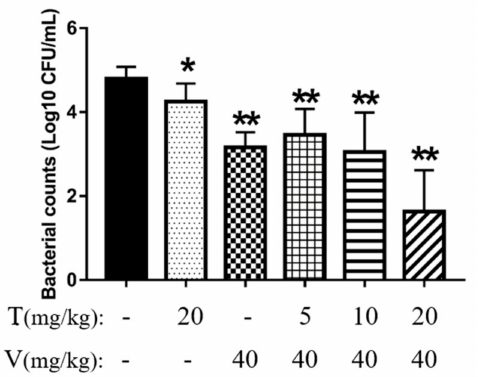
Figure 7. Bacterial counts in di ff erent mouse treatment groups. The results are expressed as the mean ± standard deviation (SD). * p < 0.05 and ** p < 0.01 indicate statistically significant and extremely significant di ff erences compared with the PBS group. T, thymol; V, vancomycin